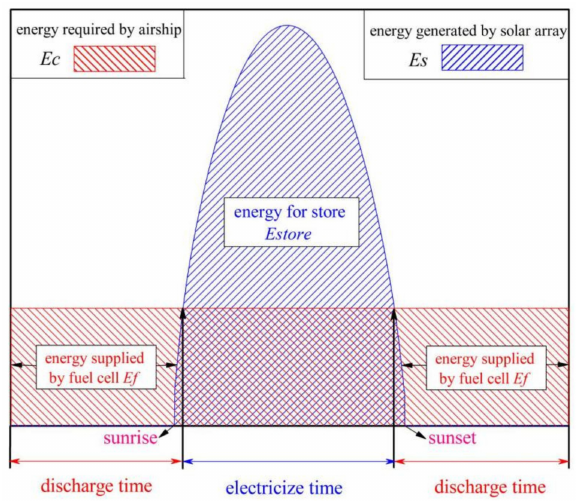
Figure 3. The process of energy